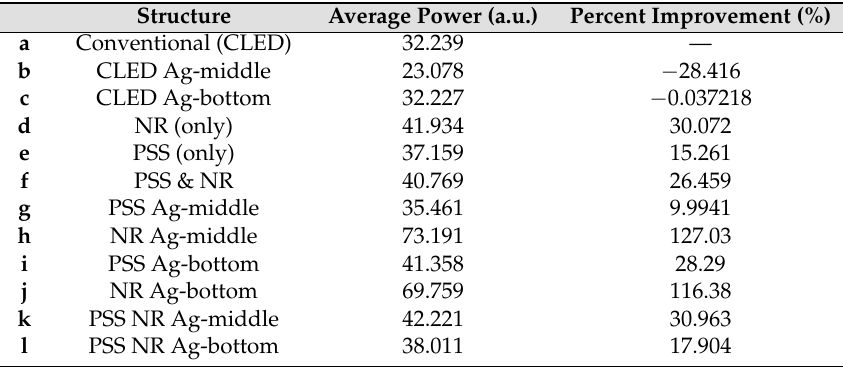
Table 5. Percent improvement of various LEDs compared to CLEDs.